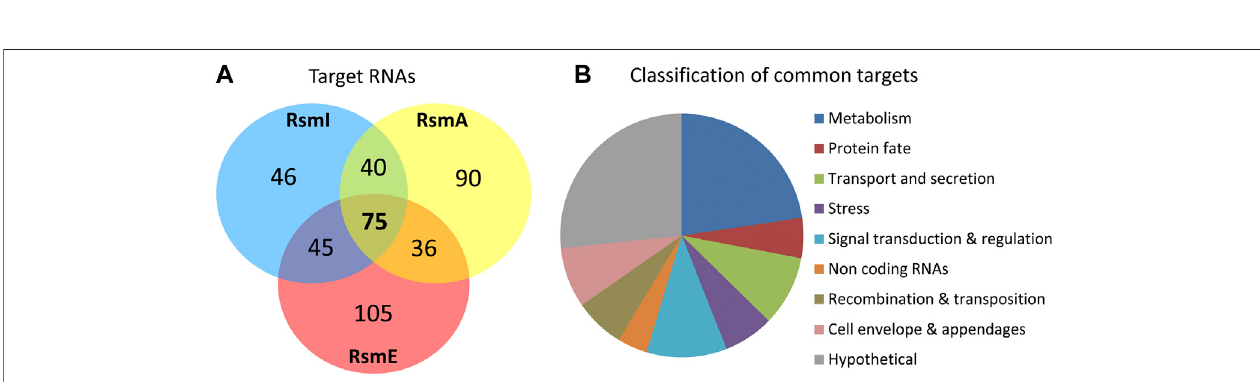
FIGURE 2 | (A) Venn diagram summarizing the number of targets identi fi ed for the three Rsm proteins in P. putida KT2440, according to the selection parameters detailed in the text. (B) Graphical representation of the different functional categories encompassing the 75 common targets.